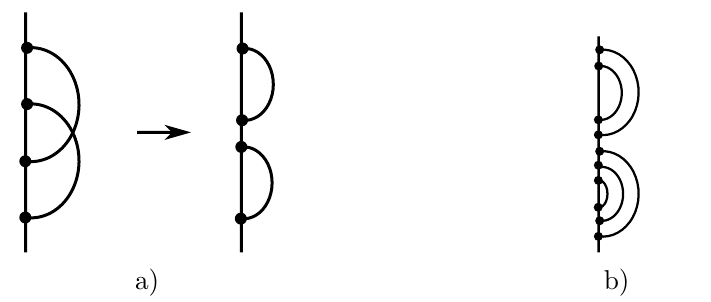
Figure 6 . Diagram corresponding to ker